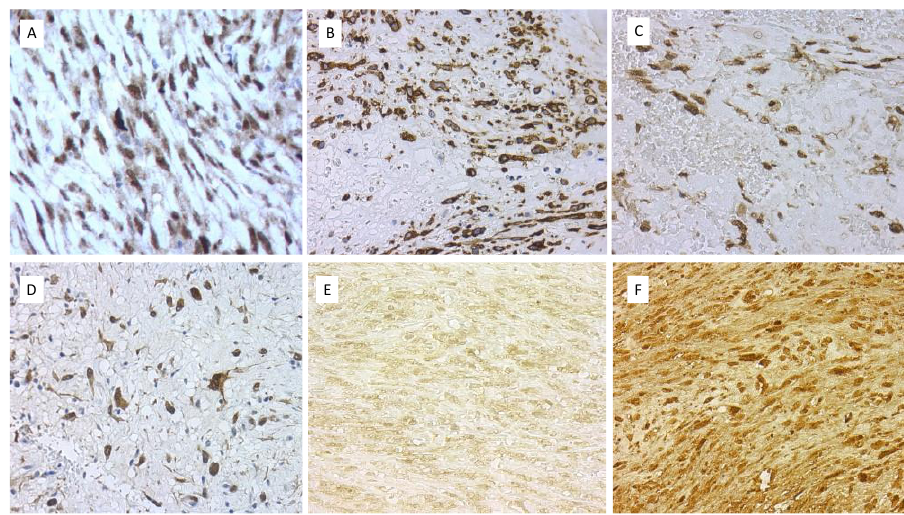
Figure 3. Immunohistochemical markers in different cases of IS. ( A ) High nuclear expression of MDM2 in the primary tumor from case 3 (40 × ). ( B ) Intense expression of CD117 in case 1 (40 × ). ( C ) Intense nuclear and cytoplasmic expression of PDGFRA in case 1 (40 × ). ( D ) Intense nuclear expression of p16 in case 2 (40 × ). ( E ) Expression of HTERT in the primary tumor from case 3 (40 × ). ( F ) Higher and intense expression of HTERT in the xenografted tumor (40 × ).